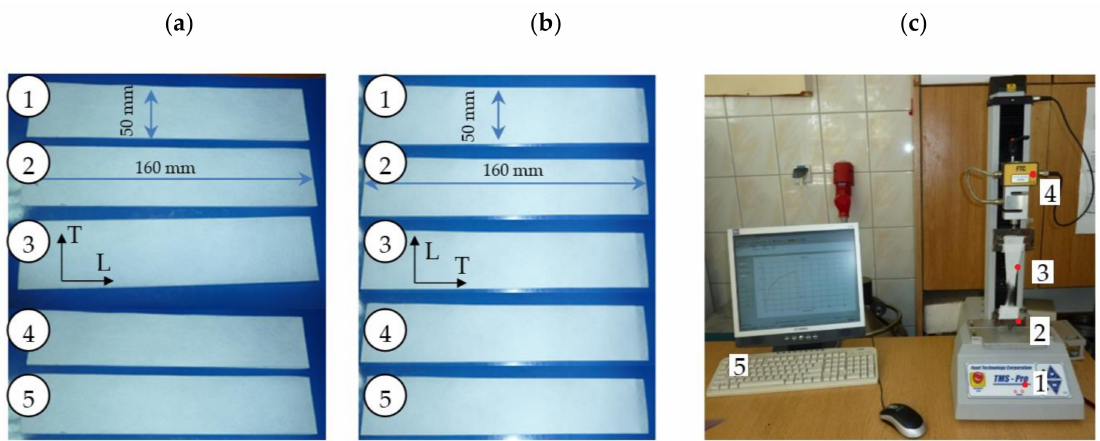
Figure 2. Photographs of samples for determining the tensile strength: ( a ) longitudinal direction, ( b ) transverse direction, ( c ) Mecmesin TMS PRO force and displacement station: 1—control panel, 2—clamping jaws, 3—sample, 4—FTC force sensor, 5—PC for recording and storing data.